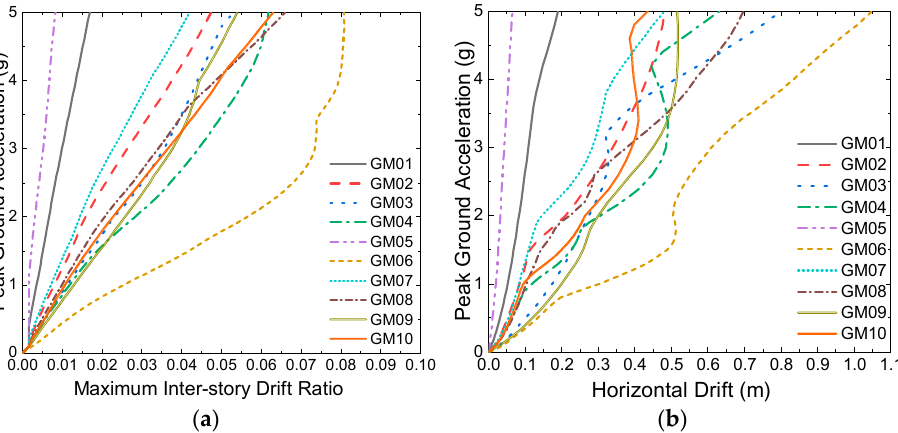
Figure 6. IDA curves under various ground motions: ( a ) IDA curves for the entire structure; ( b ) IDA curves for LRBs.